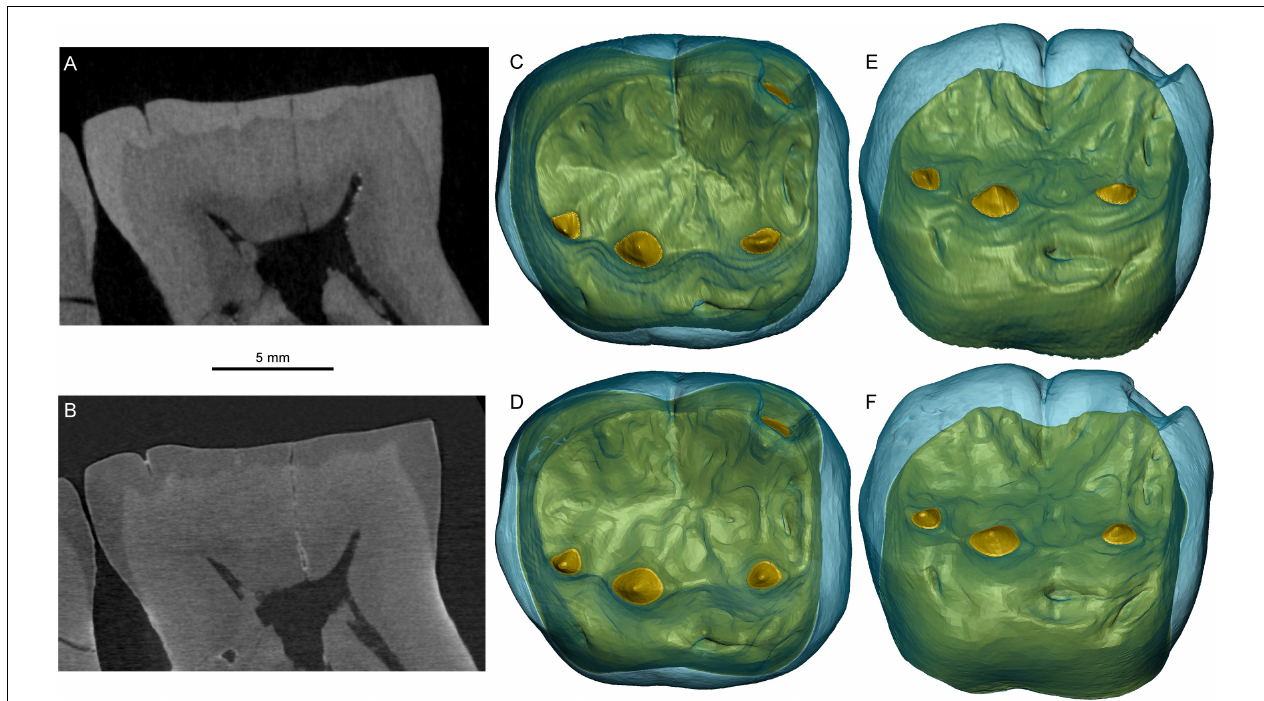
FIGURE 6 | X- µ CT- (A) and n- µ CT-based (B) mesiodistal virtual sections through the middle of the right m1 of the Sangiran 6a mandible ( Meganthropus palaeojavanicus ). The 3D renderings of the crown, respectively, generated by the X-ray-based (C,E) and neutron-based (D,F) records are shown in occlusal (C,D) , and occlusobuccal (E,F)